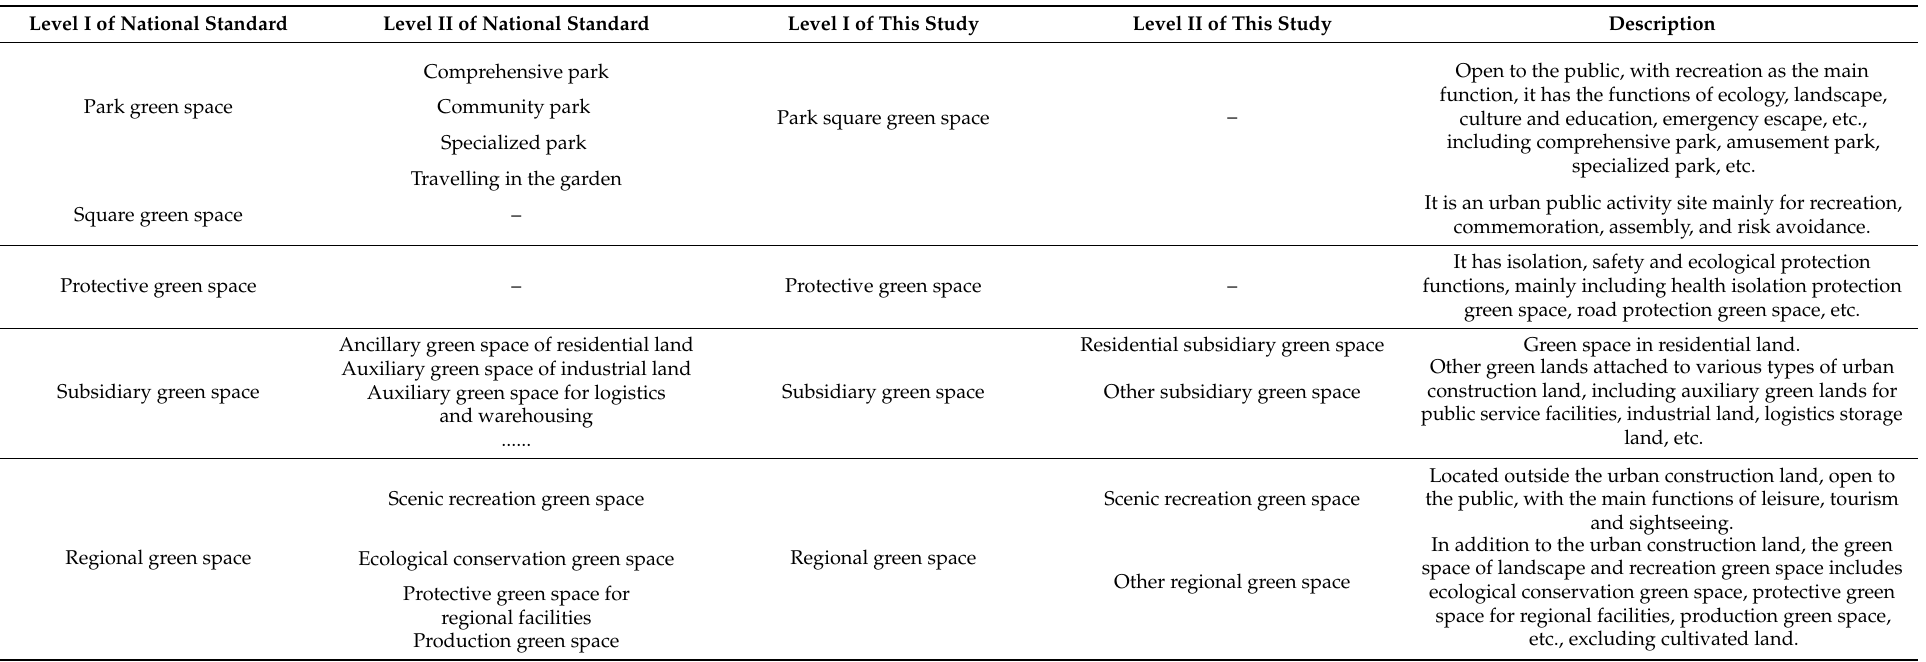
Table 2. Classification standard of urban green